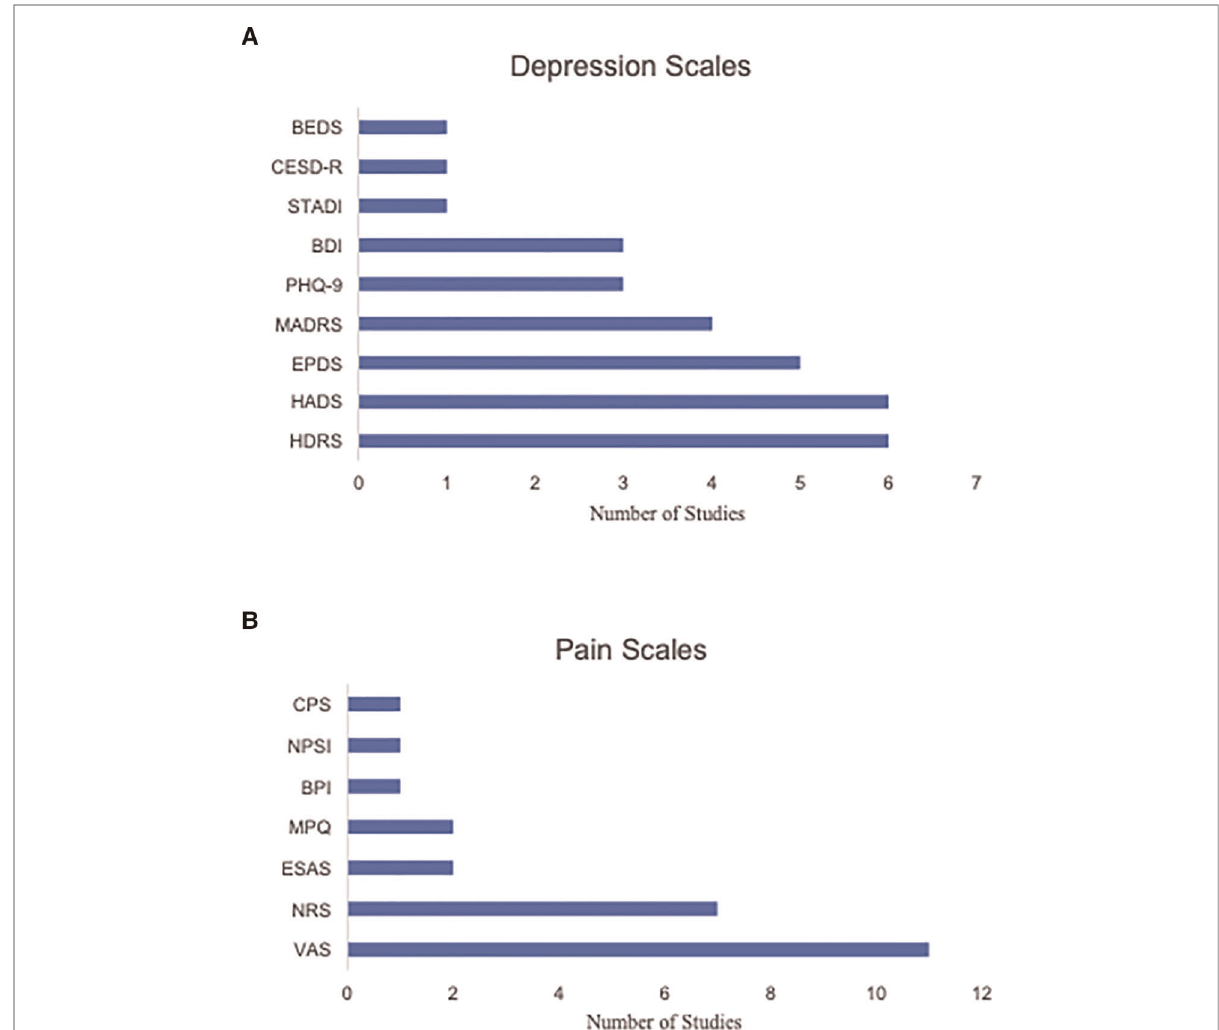
FIGURE 3 ( A ) Bar chart illustrating the frequency of various depression score measures used across the selected CDCP and CDAP studies. ( B ) Bar chart illustrating the frequency of various pain score measures used across the selected CDCP and CDAP studies. BEDS, Brief Edinburgh Depression Scale; BDI, Beck Depression Inventory; BPI, Brief Pain Inventory; CESD-R, Center for Epidemiological Studies Depression-Revised; CPS, Comparative Pain Scale; ESAS, Edmonton Symptom Assessment System; EPDS, Edinburgh Postnatal Depression Scale; HADS, Hospital Anxiety and Depression Scale; HDRS, Hamilton Depression Rating Scale; MADRS, Montgomery-Asberg Depression Rating Scale; MPQ, McGill Pain Questionnaire; NPSI, Neuropathic Pain Symptom Inventory; NRS, Numerical Rating Scale; PHQ-9, Patient Hospital Questionnaire; STADI, State- Trait Anxiety Depression Inventory; VAS, Visual Analog